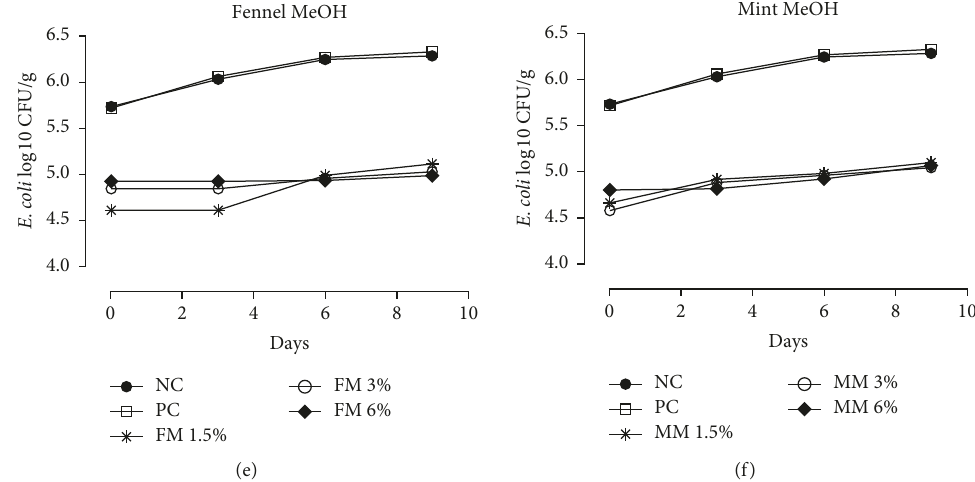
Figure 1: E. coli inhibitory activity of spice extracts in marinated minced beef under refrigerated (4 ° C) 9 d storage. NC: negative control, PC: positive control, OM: onion methanolic extracts, GM: ginger methanolic extracts, TM: turmeric methanolic extracts, CM: coriander methanolic extracts, FM: fennel methanolic extracts, and MM: mint methanolic extracts. Onion MeOH